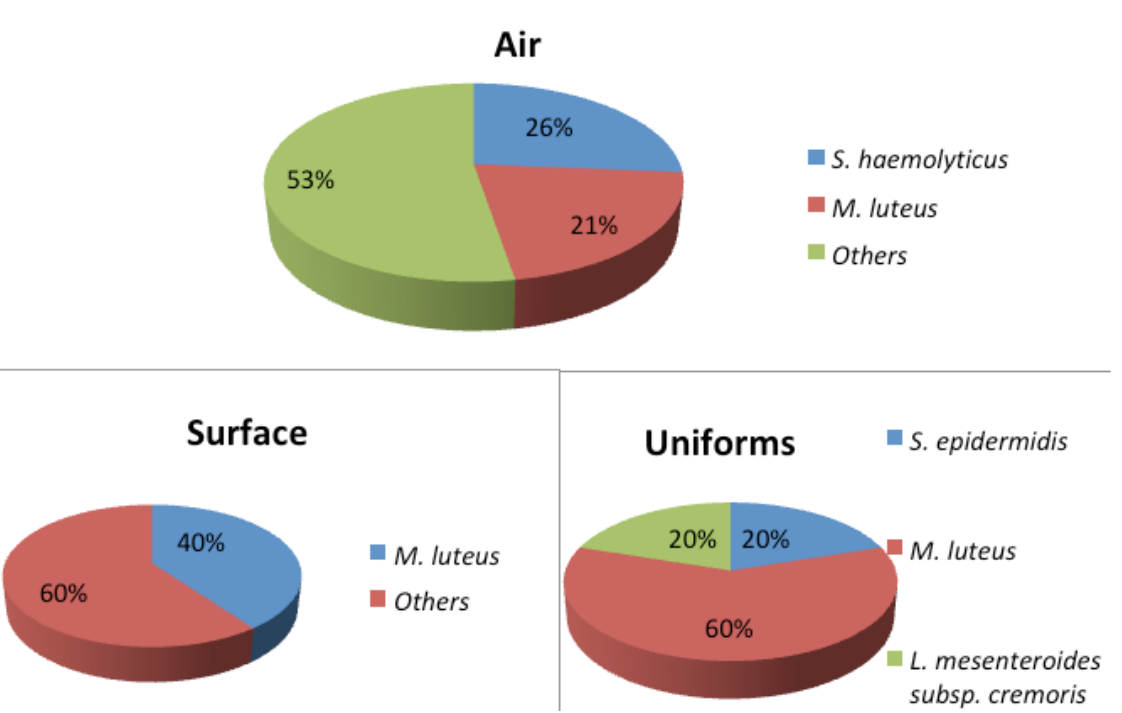
FIGURE 6 – Microorganisms identified in air, surface and uniforms samples of operating room theaters (ORT) – Hospital B.